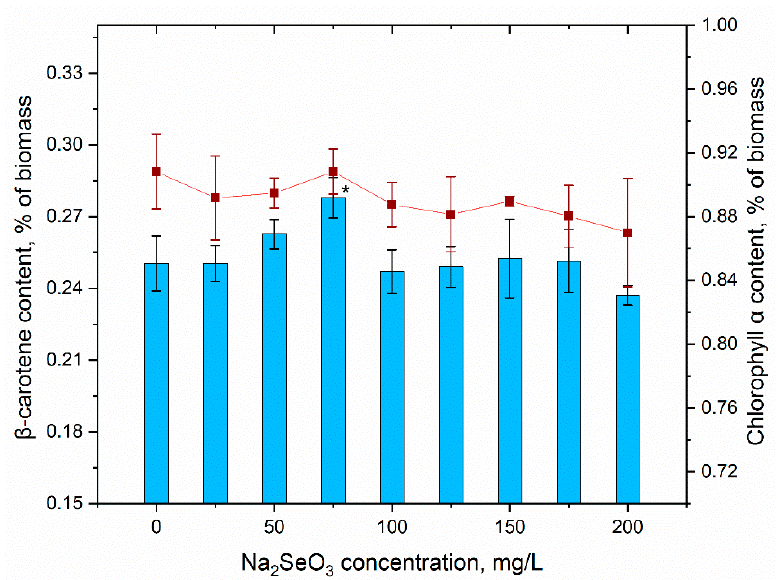
Figure 6. The content of β carotene and chlorophyll a in Arthrospira platensis biomass under condi- tions of supplementing the nutrient medium with sodium selenite (* p < 0.05 for differences between control and experimental sample; n = 3). The error bars represent the standard deviation of the measurements.